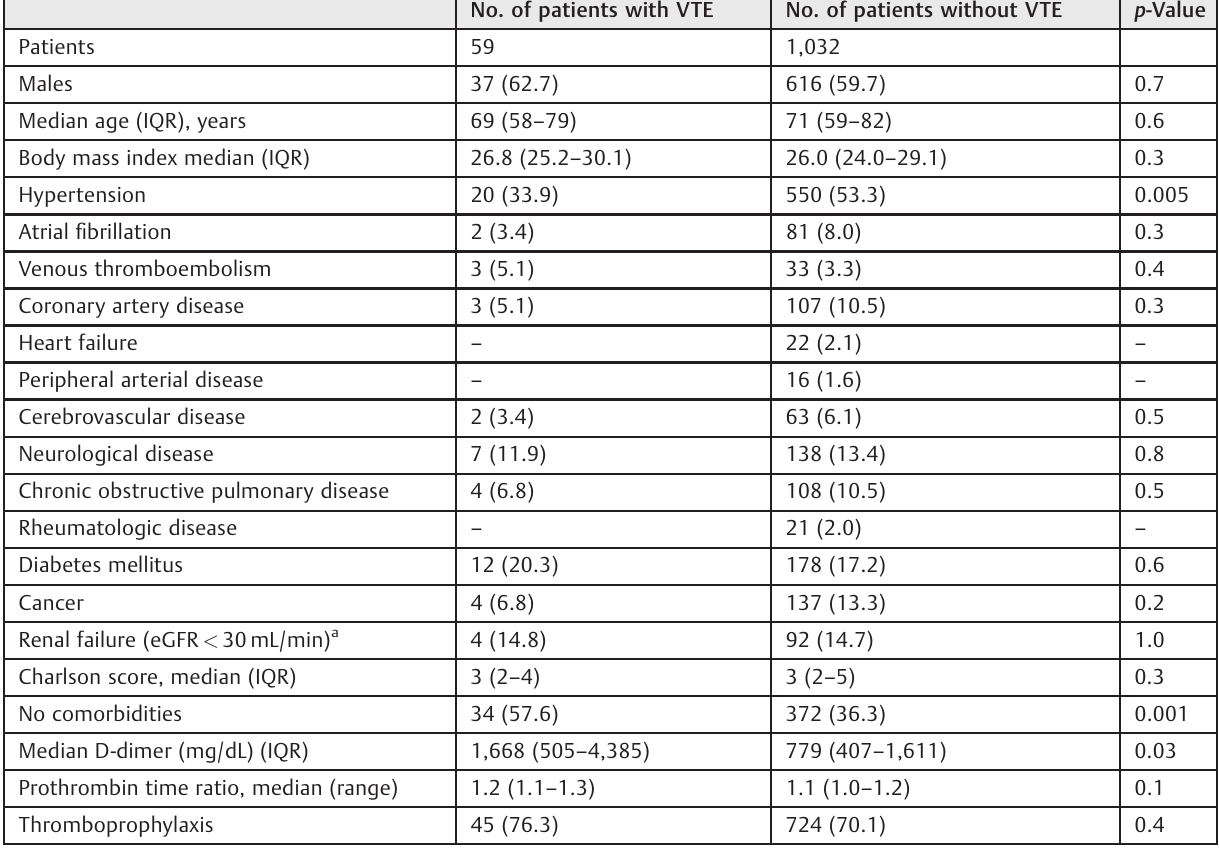
Table 2 Characteristics of patients with and without venous thromboembolism No. of patients with